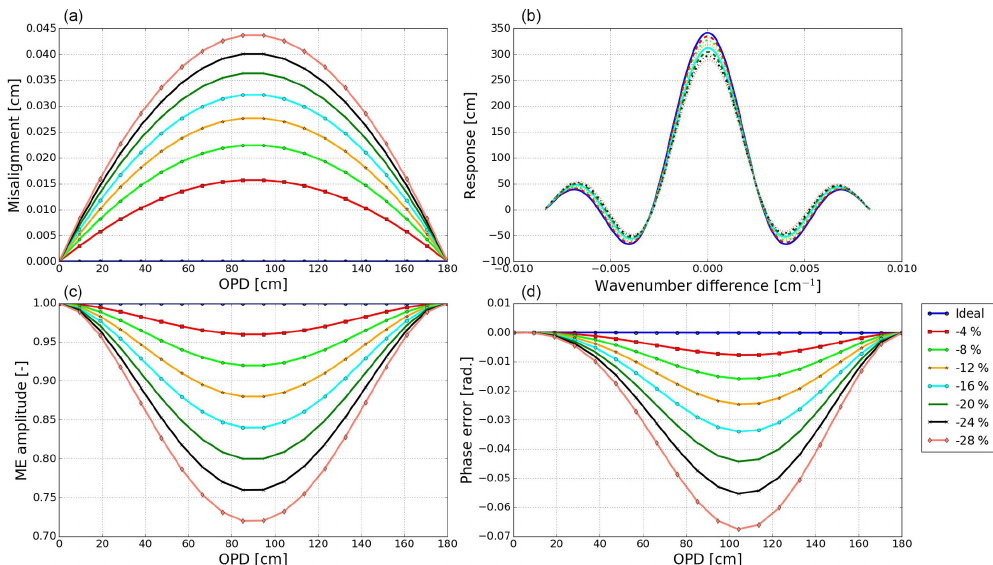
Figure 12. Simulated negative ME deviations along with the OPD. Panel (a) demonstrates the misalignment, panel (b) shows the resulting ILS, panel (c) shows the resulting ME amplitude, and panel (d) shows the resulting PE.